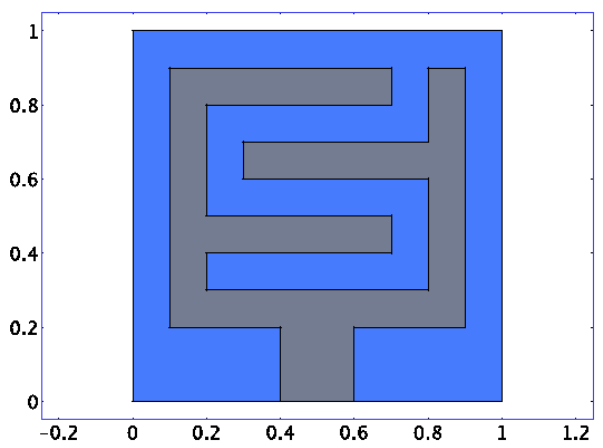
Figure 1. Geometry of the numerical